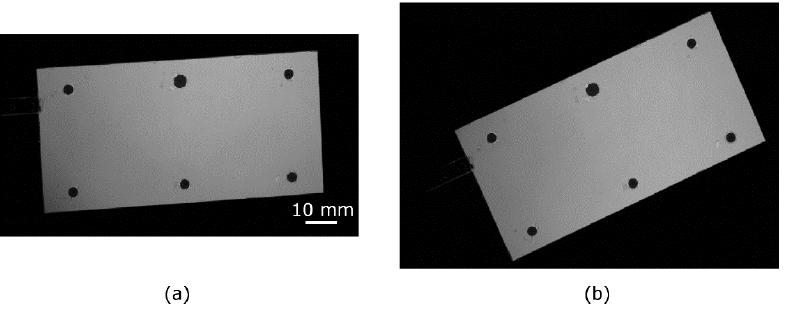
Table 1. Results of image alignment by each method.